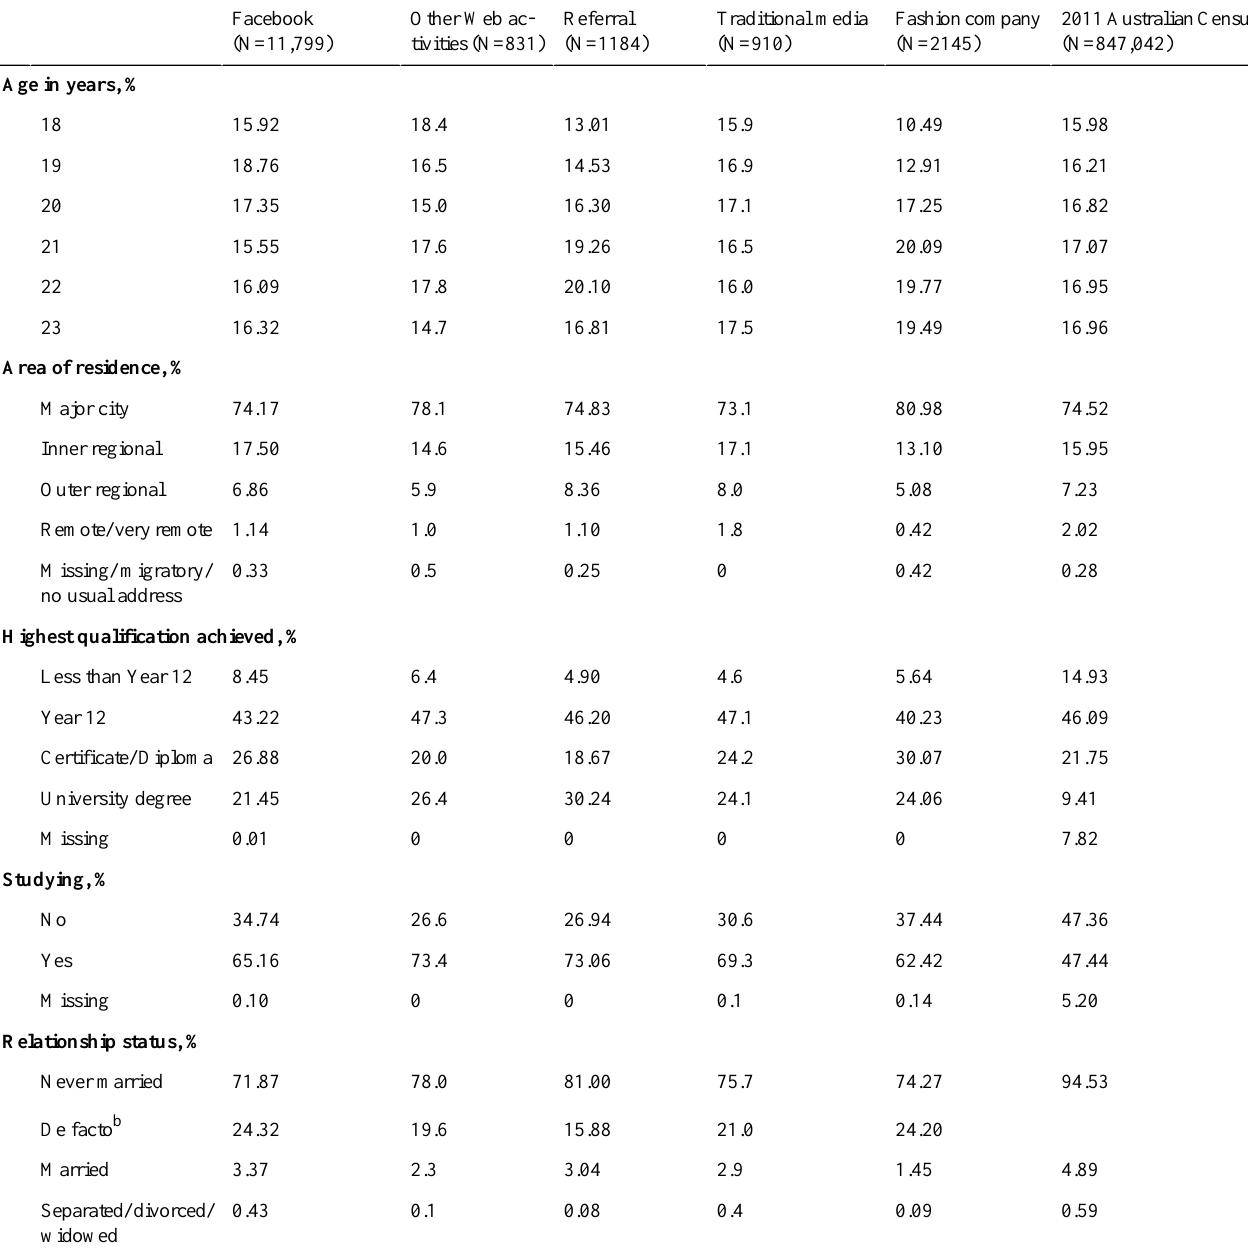
Table 2. Demographic characteristics by recruitment strategy a of 18-23 year old women from the ALSWH 1989-95 cohort compared with 18-23 year old women from the 2011 Australian